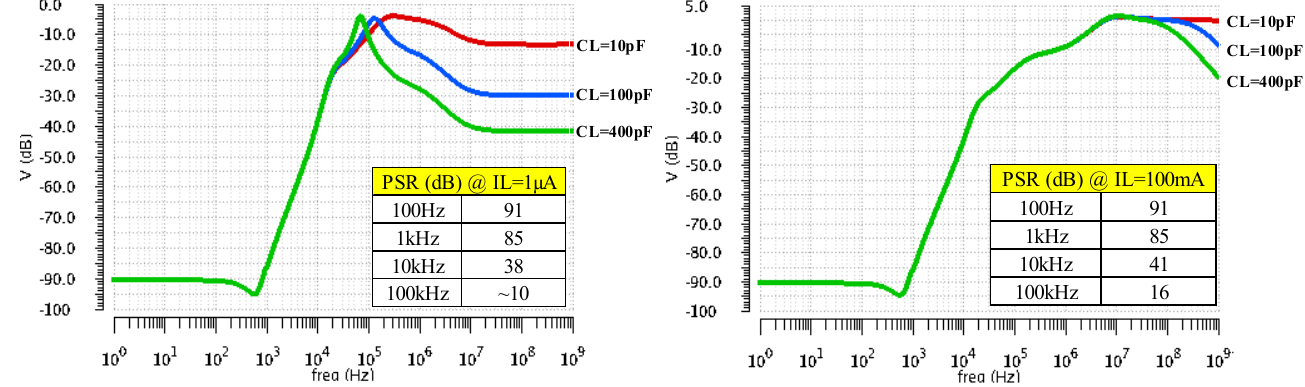
Figure 8. The phase margin for (cid:1846) (cid:3010)(cid:3015)(cid:3015)(cid:3006)(cid:3019) , (cid:1846) (cid:3004)(cid:3016)(cid:3019)(cid:3006) , and (cid:1846) (cid:3013)(cid:3005)(cid:3016) when CL and IL are swept over their entire range of values: CL = 0 to 400 pF and IL= 0 to 100 mA.